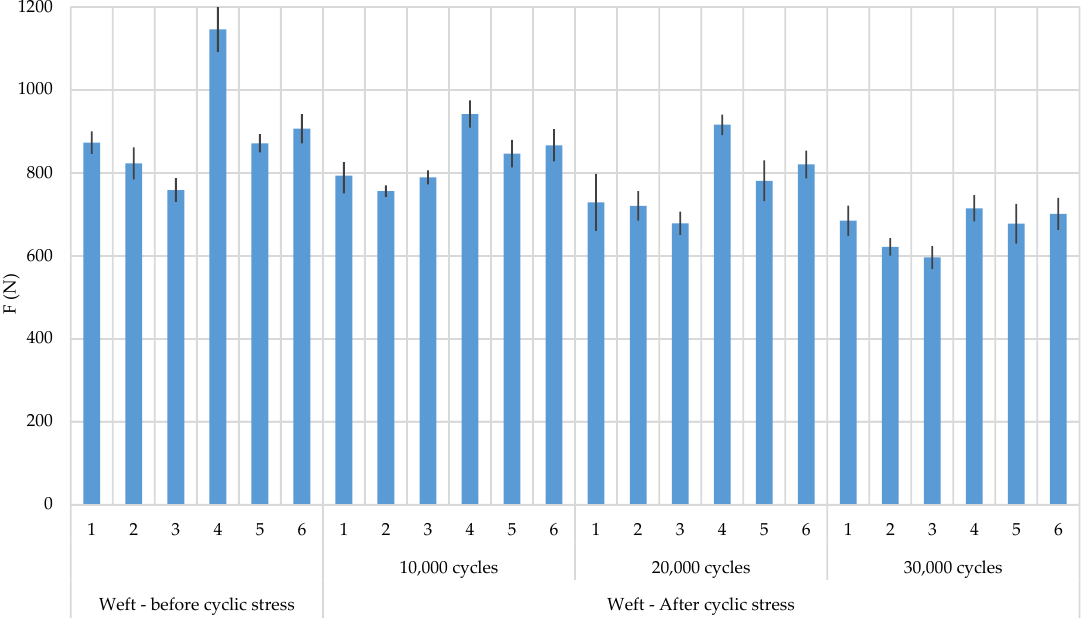
Figure 5. Breaking force of samples in weft direction, before and after subjection to cyclic loads, with error display.